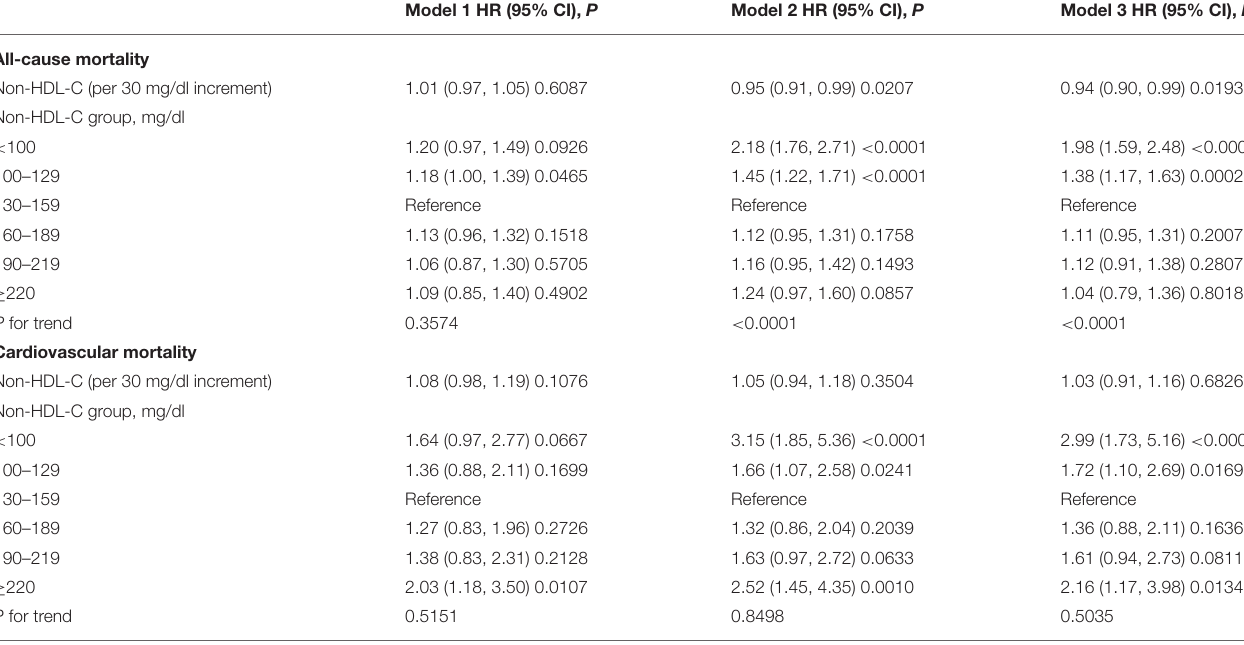
TABLE 2 | Multivariable cox regression analysis of non-HDL-C with all-cause and cardiovascular mortality.